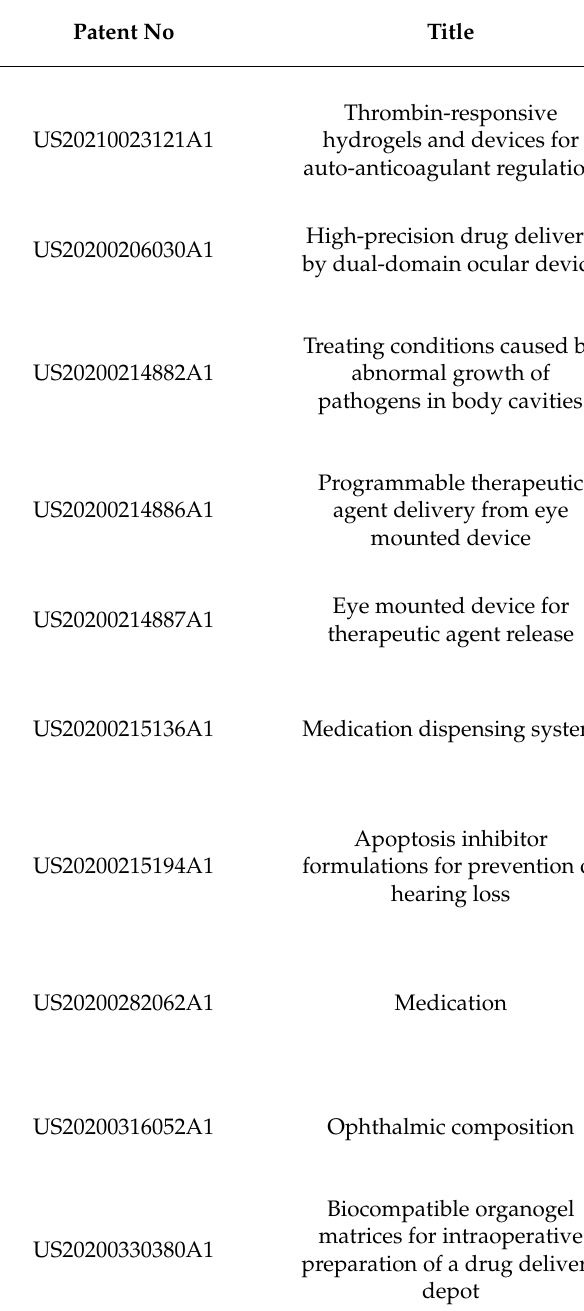
Table 2. Recent patents on